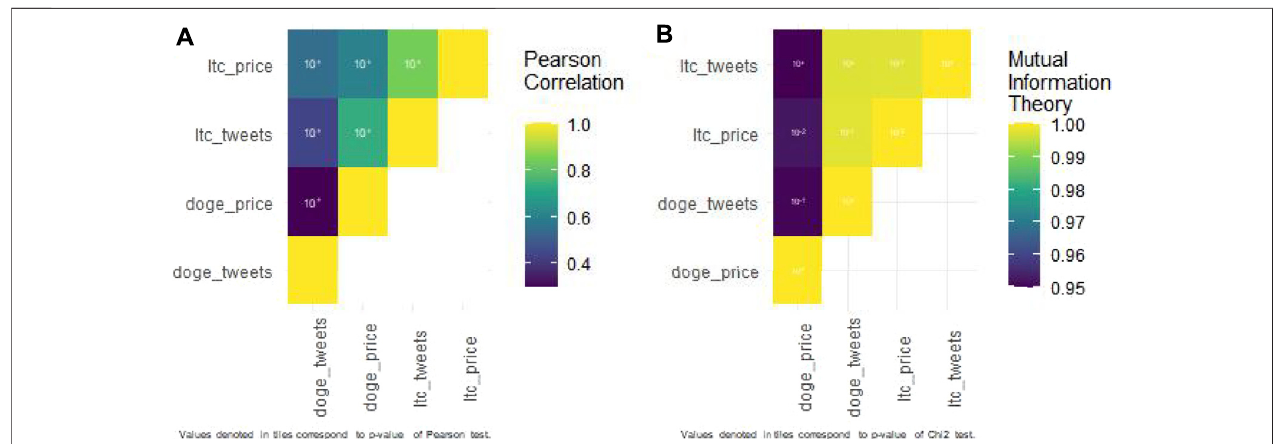
FIGURE 6 | Correlation and association heatmaps concerning tweets and cryptocurrency price.